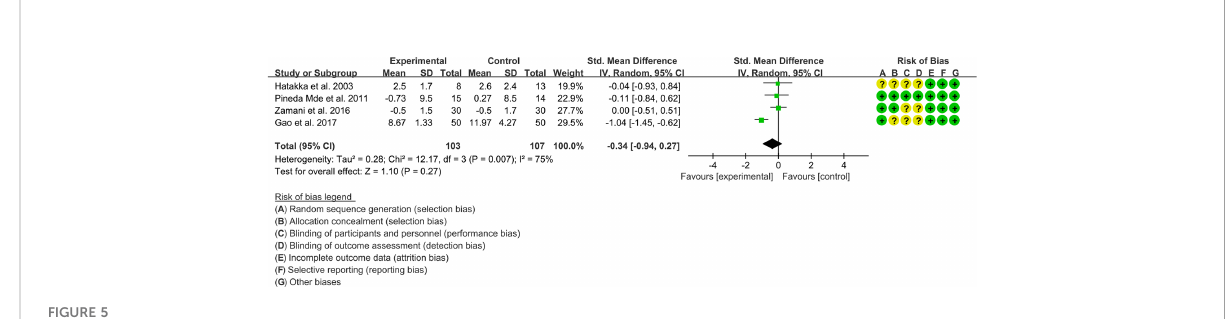
FIGURE 5 Tender joint count (CI, con fi dence interval; SD, standard